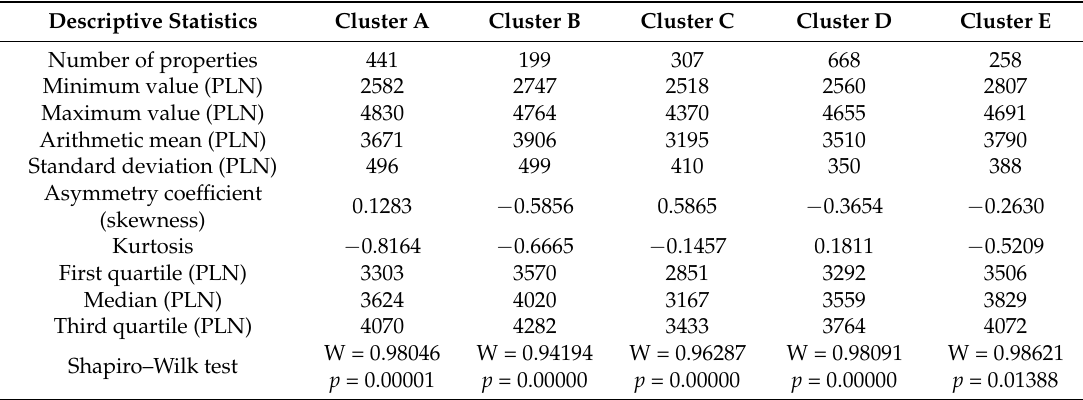
Table 4. Descriptive statistics for property prices in different clusters.